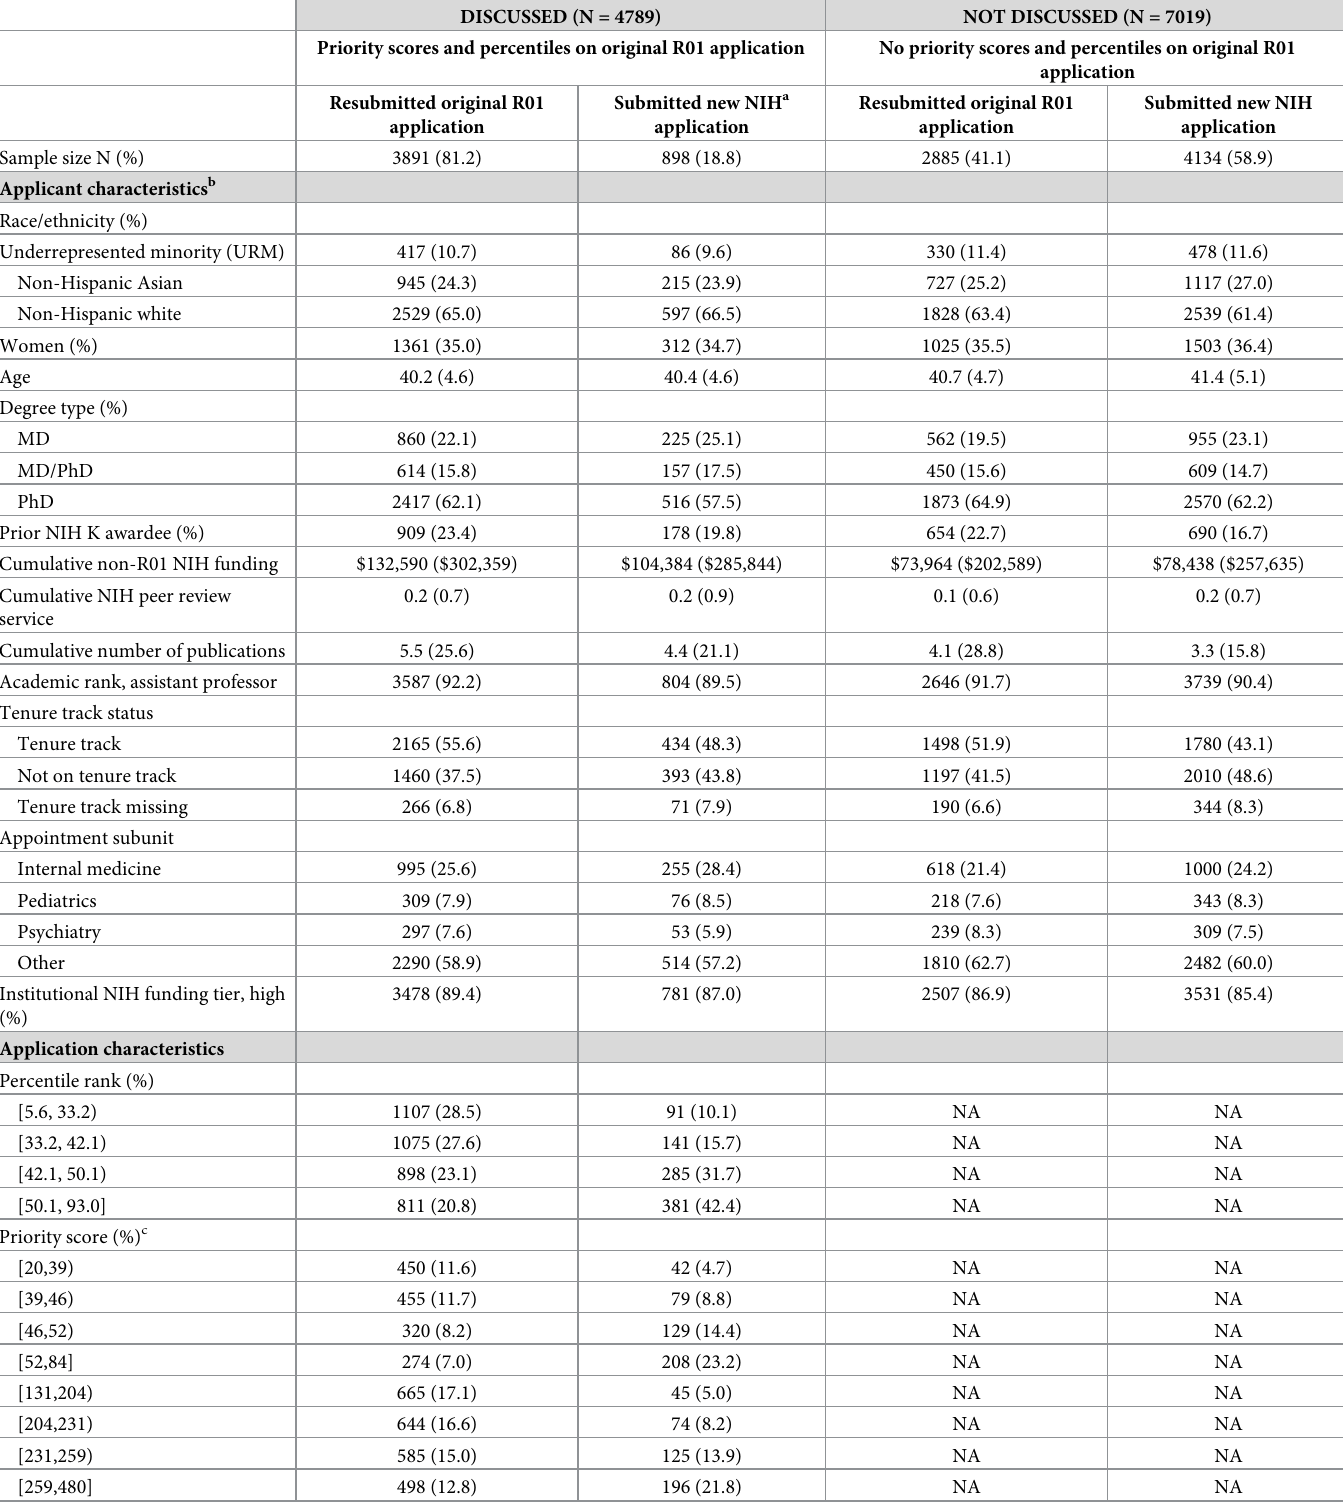
Table 2. Applicant and application characteristics of first-time R01 applicants, unadjusted covariates